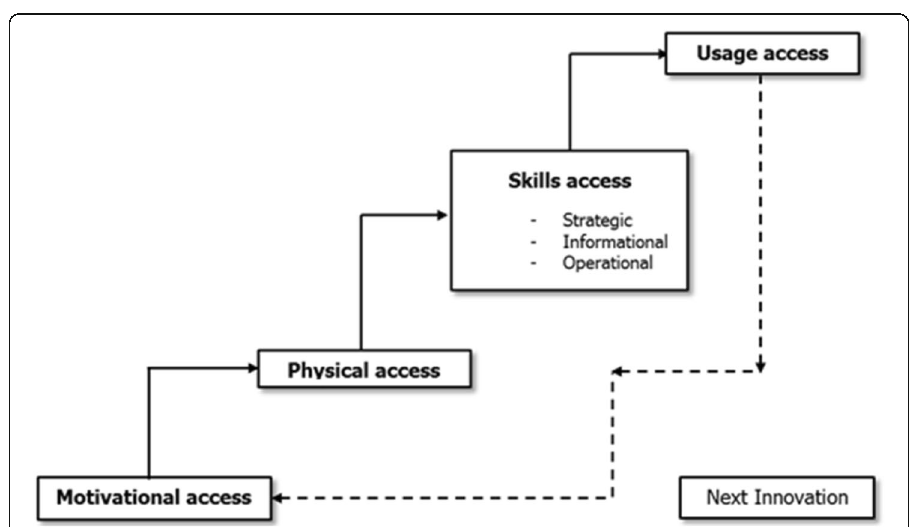
Fig. 1 Successive kinds of access to digital technologies (van Dijk, 2005, p.